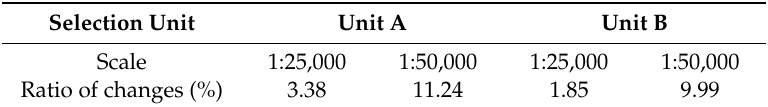
Table 2. Magnitude of distribution range changes.